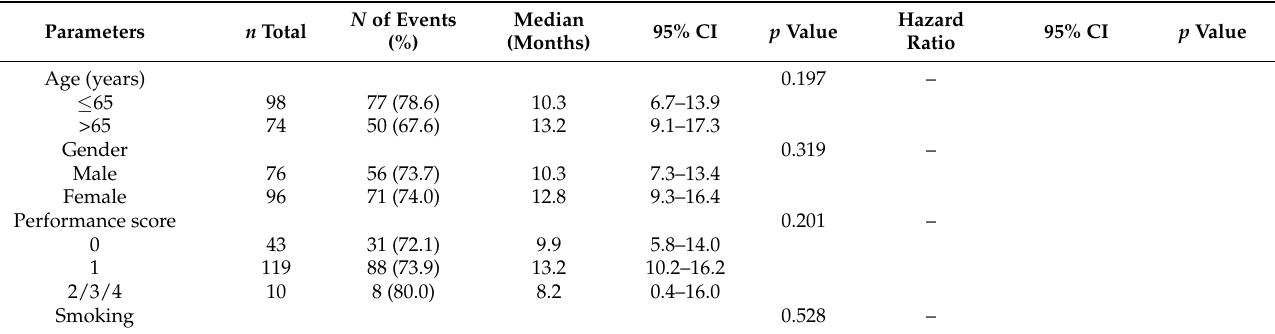
Table 3. Univariate and multivariate analysis of prognostic factors for PFS of osimertinib in patients treated with